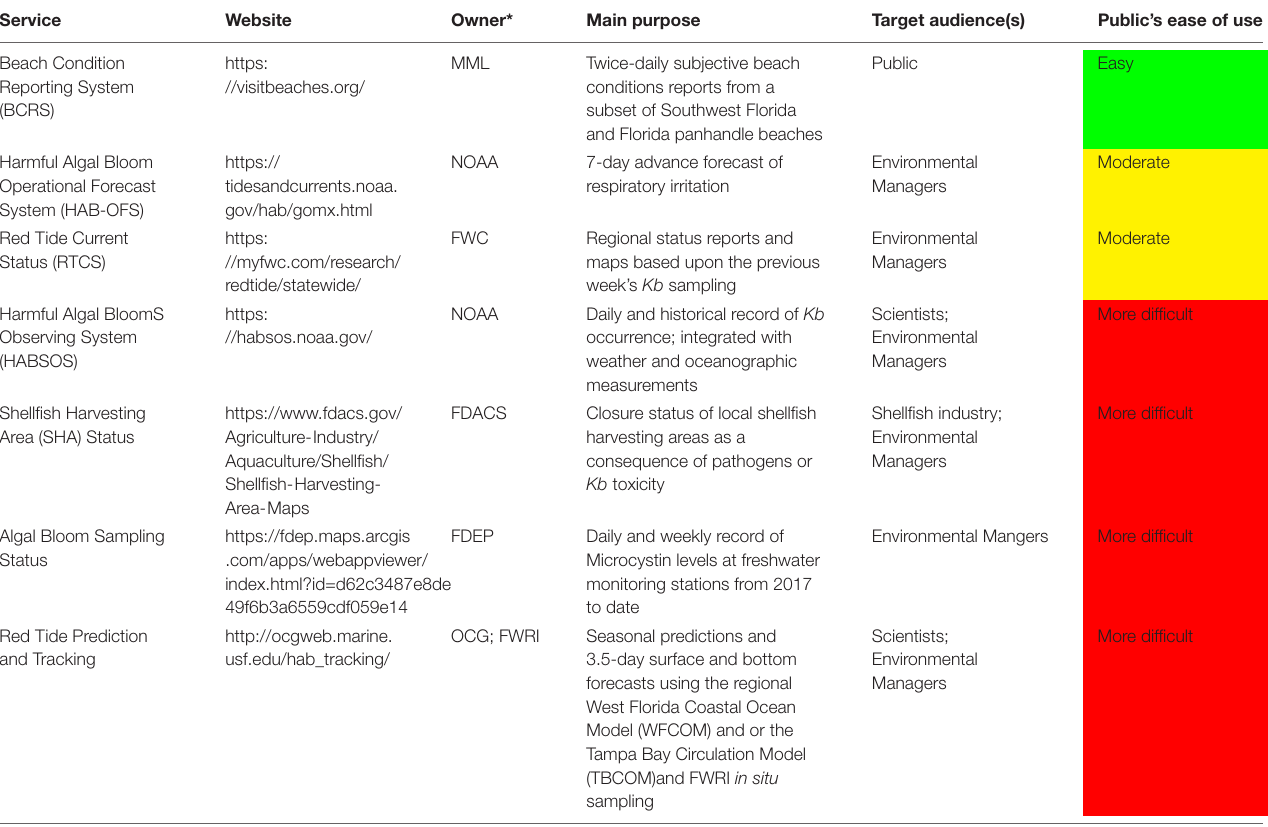
TABLE 1 | Some means of public notification, audiences, and user-friendliness Karenia brevis